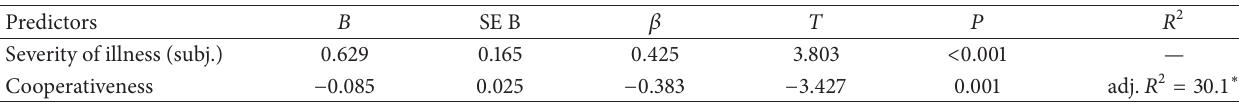
Table 3: Significant predictors in stepwise regression analysis with dependent variable illness-related work stress (for the full list of sociodemographic/illness characteristics and personality dimensions as predictors see Table 2). Predictors 𝐵 SE B 𝛽 𝑇 𝑃 𝑅 2 Severity of illness (subj.) — Cooperativeness adj. 𝑅 2 = 30.1 ∗ ∗ 𝑃 < 0.001